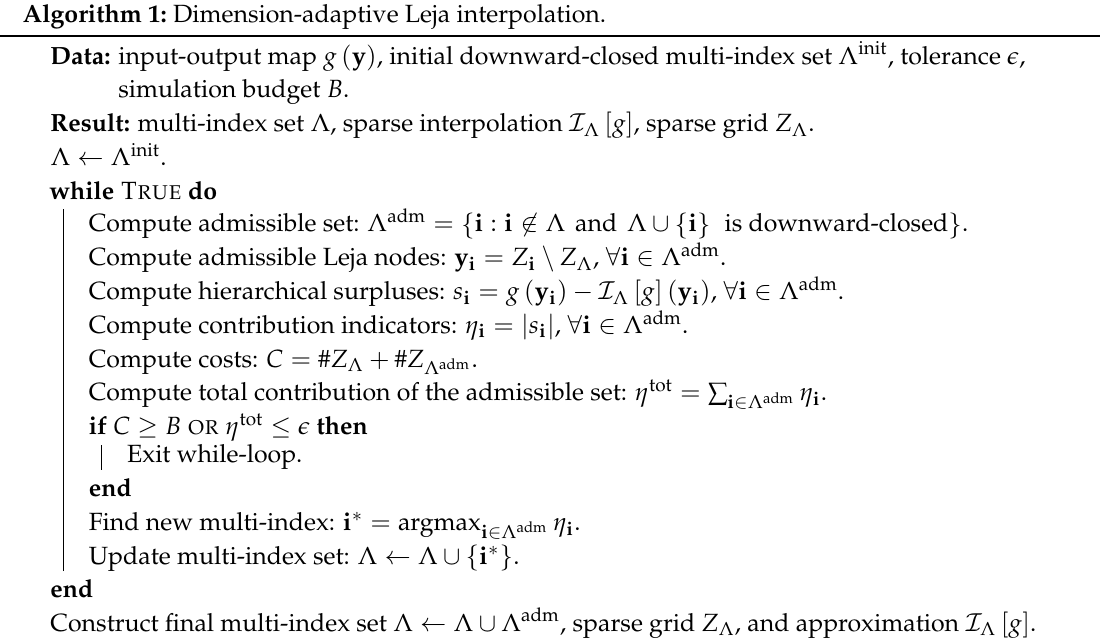
Algorithm 1: Dimension-adaptive Leja